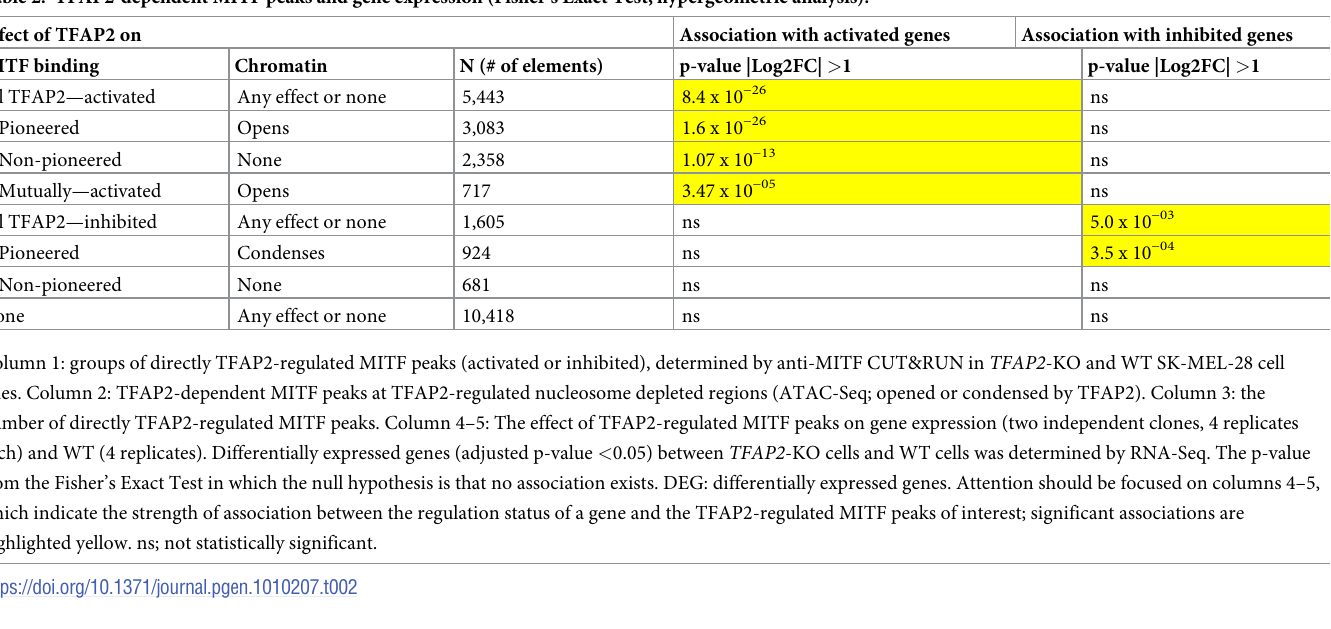
Table 2. TFAP2-dependent MITF peaks and gene expression (Fisher’s Exact Test; hypergeometric